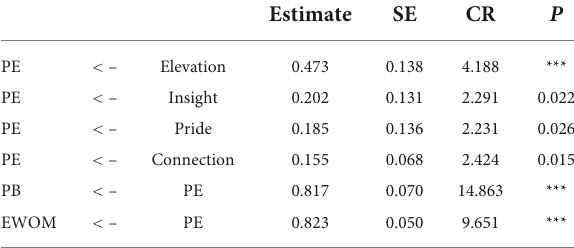
TABLE 9 Standardized parameter estimates, standard errors, and p -values for the structural model.